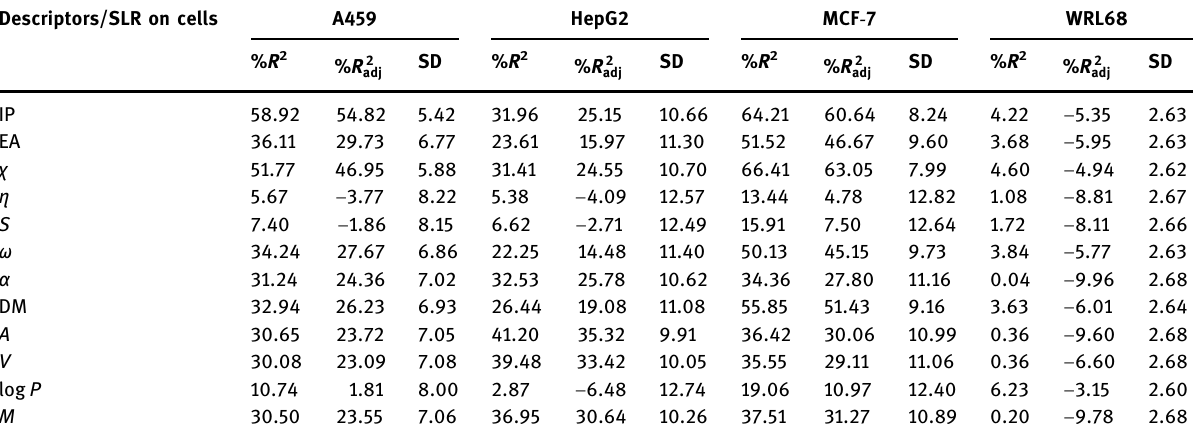
Table 5: Correlation coe ffi cients ( R 2 ) , adjusted correlation coe ffi cients ( ) R adj2 , and SDs of SLR between chosen descriptor and cell lines